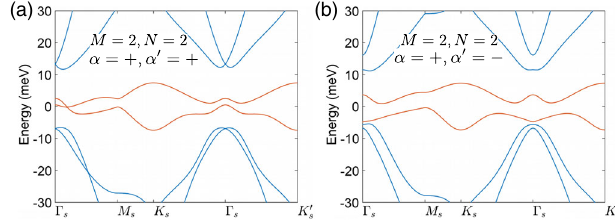
FIG. 3. The band structures of ( 2 þ 2 )-layer twisted multilayer graphene at the first magic angle θ ¼ 1 . 05 ° with the more realistic interlayer hopping Eq. (7). (a) The two bilayers have the same stacking chirality, and (b) the two bilayers have opposite stacking